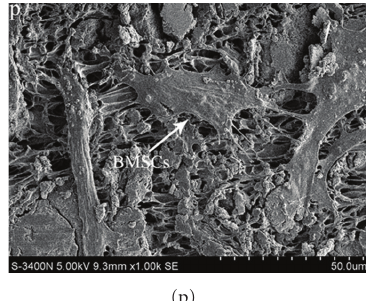
Figure 3: (a) Morphological observation of BMSCs cultured on the core-sheath structure composite sca ff old by SEM after 4 hours ( × 3 . 0 k). Note: the arrows point to the BMSCs adhered on the sca ff old and the pseudopodium of the cells. (c and d) Morphological observation of BMSCs cultured on the core-sheath structure composite sca ff old by SEM after 2 days ( × 500,1000). Note: the arrows point to the BMSCs stretched onto the sca ff old. (g and h) Morphological observation of BMSCs cultured on the core-sheath structure composite sca ff old by SEM after 6 days ( × 300,1000). Note: the arrows point to the BMSCs. (k, l, m, and n) Morphological observation of BMSCs cultured on the core-sheath structure composite sca ff old by SEM after 14 days ( × 500,1000). Note: (k and l) the arrows point to the BMSCs and secreted ECM by BMSCs. (m and n) the arrows point to the BMSCs growed into the holes of the sca ff old. (b) Morphological observation of BMSCs cultured on the PLGA/ β -TCP skeleton after 4 hours ( × 3 . 0 k). (e and f) Morphological observation of BMSCs cultured on the PLGA/ β -TCP skeleton after 2 days ( × 500,1000). Note: the arrows point to the BMSCs. (I and j) Morphological observation of BMSCs cultured on the PLGA/ β -TCP skeleton after 6 days ( × 500,1000). Note: the arrows point to the BMSCs. (o and p) Morphological observation of BMSCs